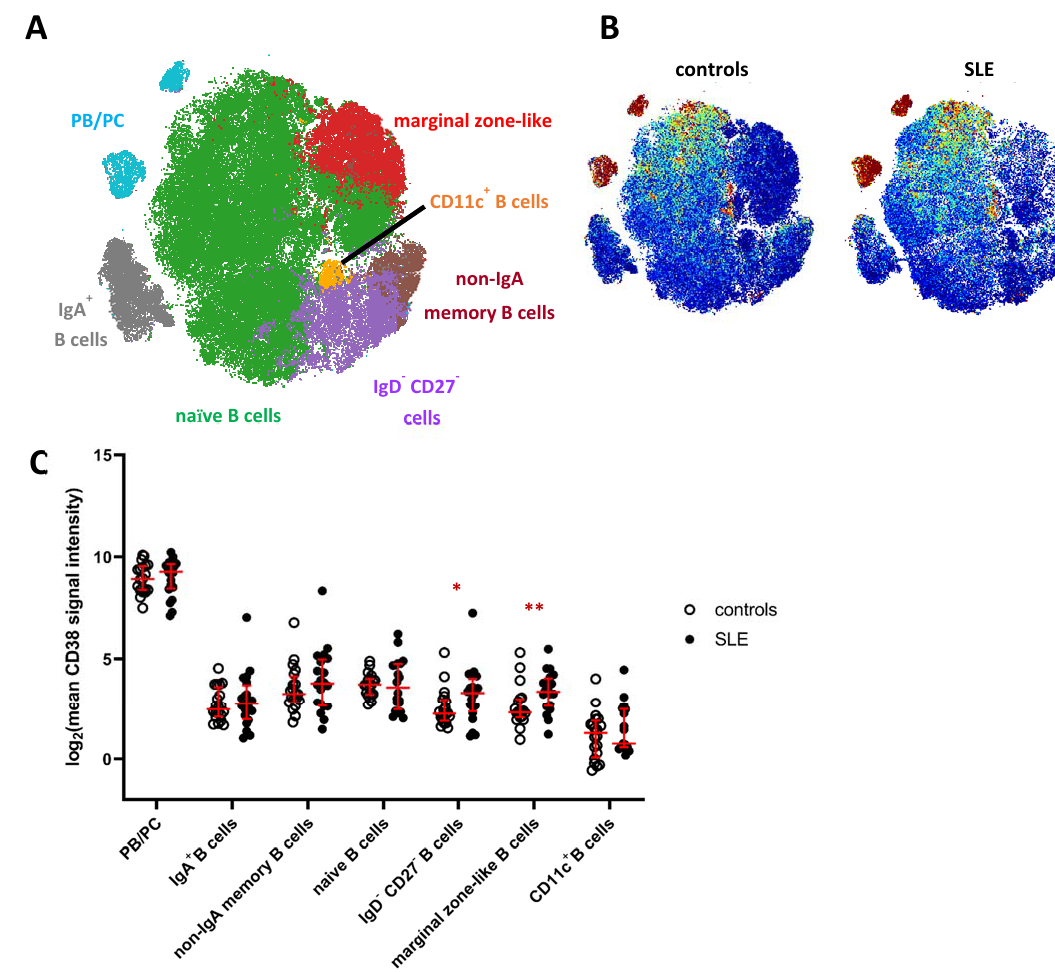
Figure 2. CD38 expression across B cell subsets in patients with SLE. ( A ) t-SNE map showing clusters of CD19 + B cells generated by FlowSOM from the mass cytometry dataset. Clusters comprising naive B cells (green) and PB/PC (blue) were merged for further analyses (Supplementary Figure S3). ( B ) CD38 expression across B cells in SLE patients and controls. Both plots show concatenated data of the respective group. ( C ) Comparison of CD38 expression across major clusters as depicted in ( A ). Each dot represents the log 2 of mean CD38 signal intensity (SI) of the indicated subset of one donor. Red lines indicate medians and interquartile ranges. * indicate significantly different CD38 expression in SLE patients vs. controls revealed by Mann–Whitney testing (* p < 0.05; ** p < 0.01;).